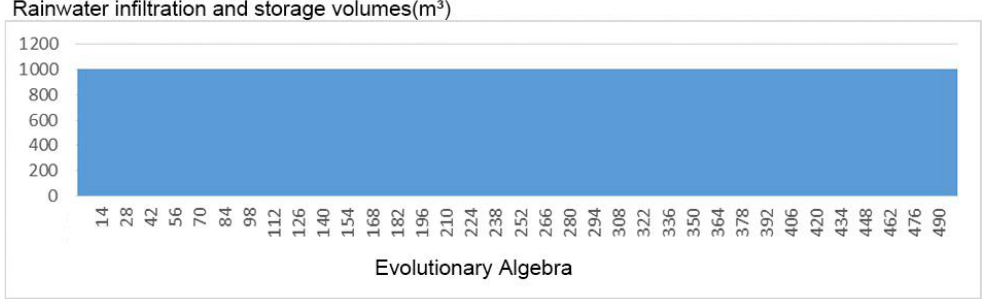
Figure 4. Evolutionary process of maxima in Pareto-optimal solutions for rainwater infiltration and storage objectives.